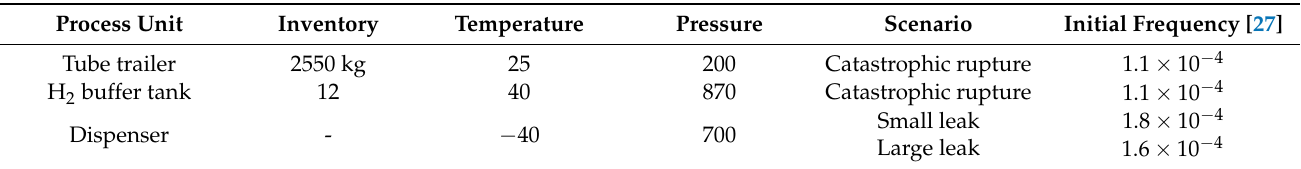
Table 2. Accident scenarios of the GHRS system. Scenarios are defined for the individual units, and the operating conditions of the units and the corresponding initial frequency values obtained from literature are provided.